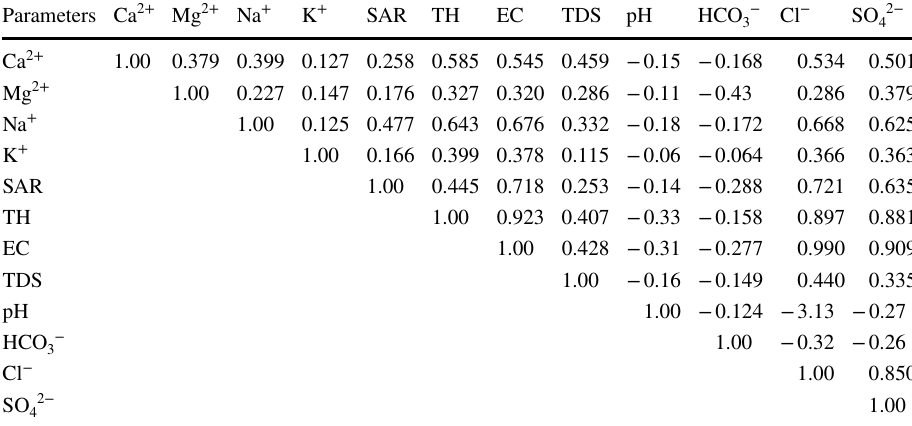
Table 3 Pearson’s correlation coefficient of physiochemical parameters of groundwater